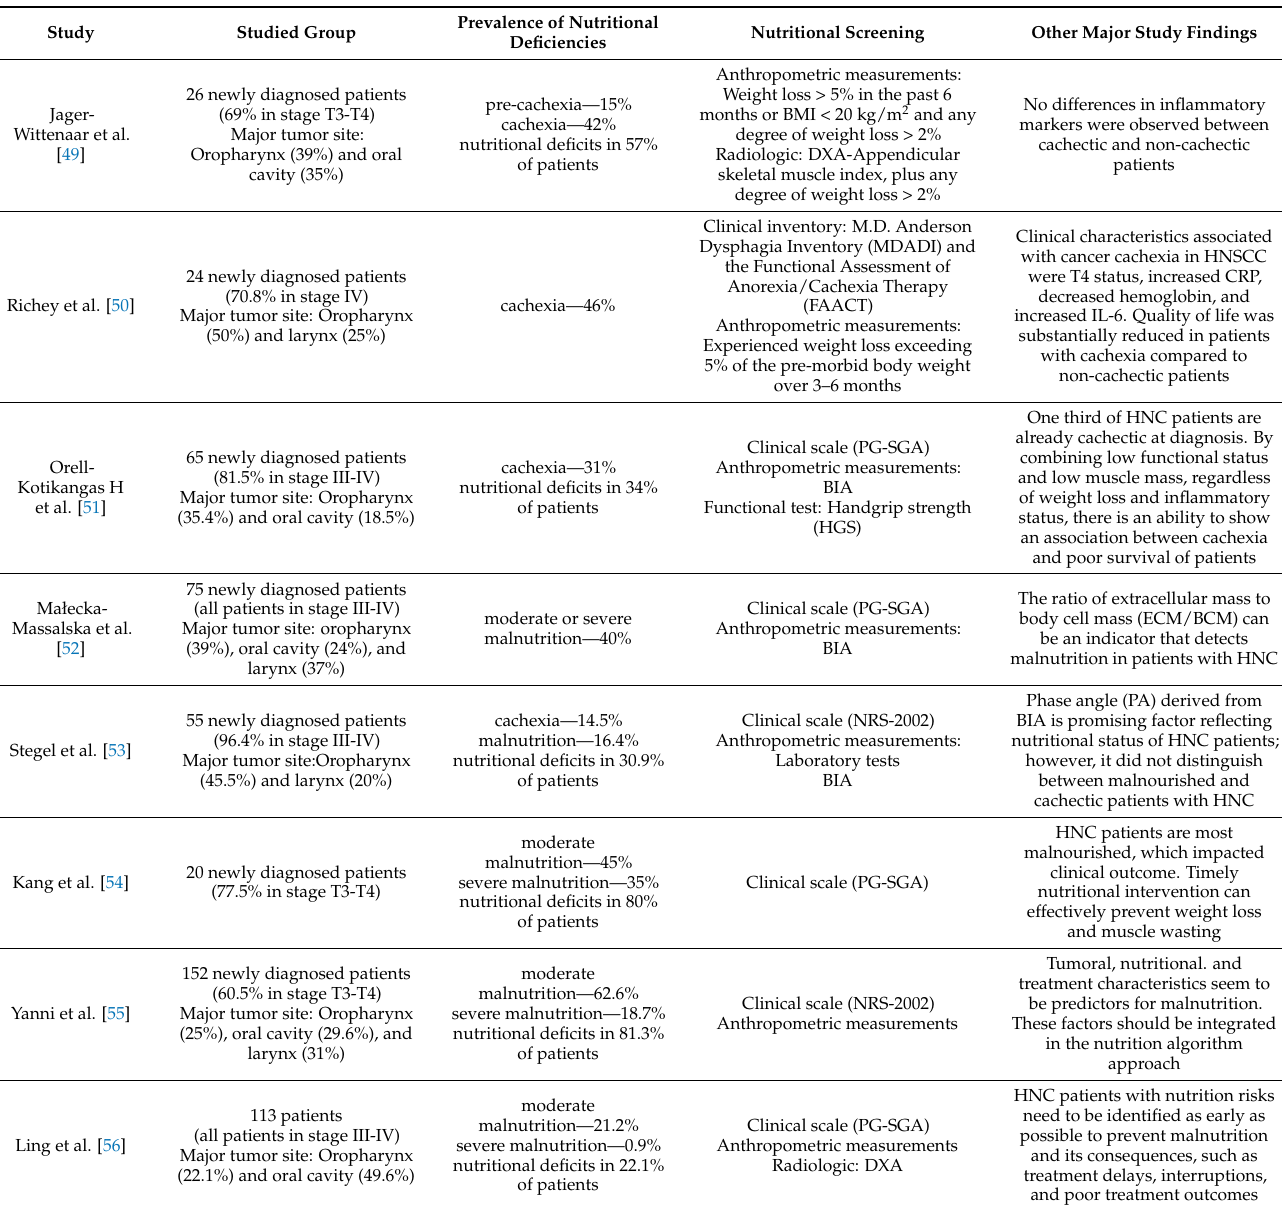
Table 1. Prevalence of malnutrition, sarcopenia and cachexia and clinical tools used for the detection of nutritional deficiencies in therapy naïve HNC